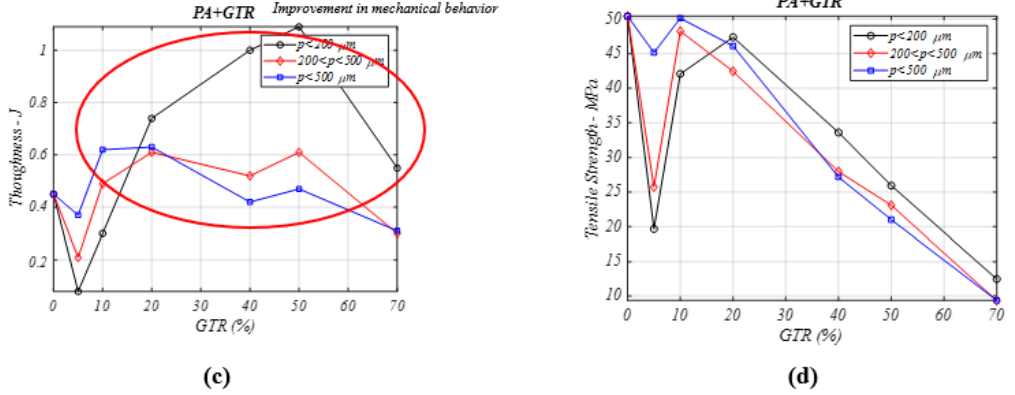
Figure 5. Mechanical properties analysis for different percentages of PA/GTR composites and particle diameters: ( a ) elongation at break (%), ( b ) Young ’s modulus (MPa), ( c ) toughness (J) ( d ) tensile stress (MPa).